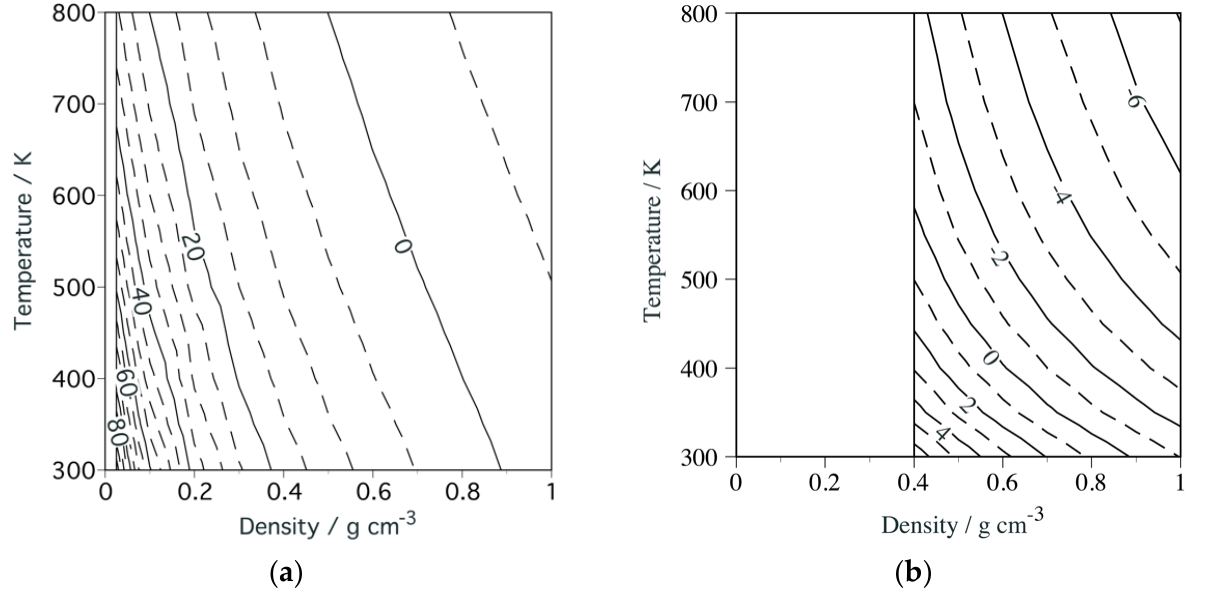
Figure 13. Density and temperature dependence of ∆ p K w , the difference between the p K w ( ρ , T ) and p K w (1.0 g cm − 3 , 273.15 K), where ρ and T are the solvent water density and the temperature of the system, respectively. The theoretical result of this work and experimental values are shown in parts ( a ) and ( b ), respectively. These figures are reprinted with permission from JPCB , 2006 , 110 , 8451. Copyright 2006 American Chemical Society.